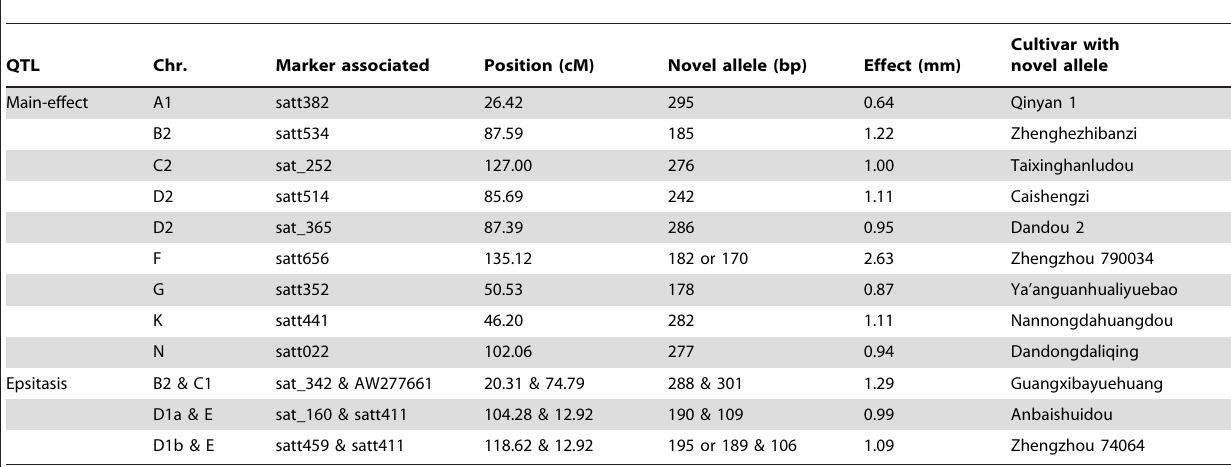
Table 2. The information of novel allele for QTL with r 2 larger than